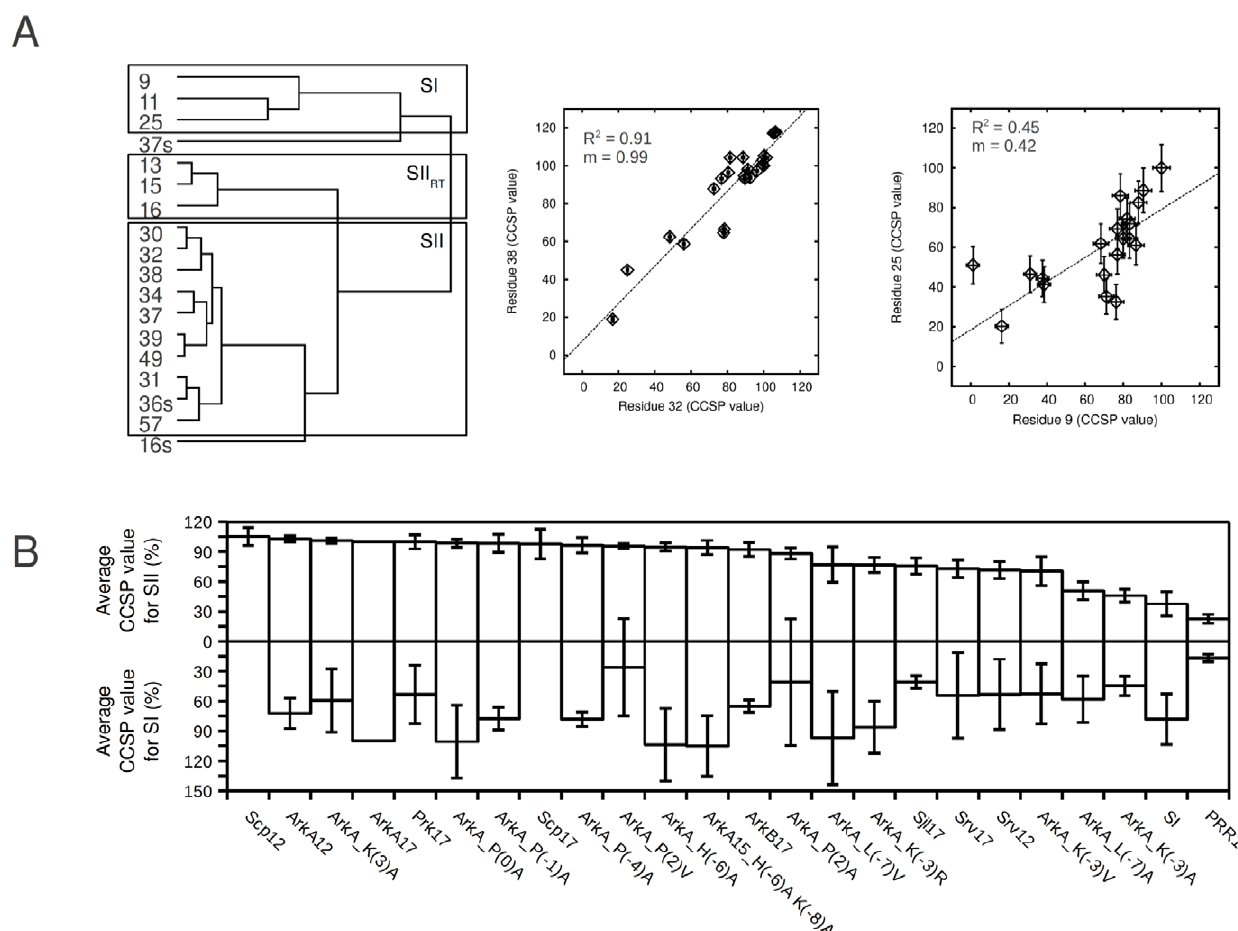
Figure 5. CCSP analysis of 24 AbpSH3-peptide complexes. (A) Left. CCSP values from 24 different peptide complexes are used in multiple pairwise comparisons to group correlated residues into a dendogram where the shorter the line connecting items indicates a closer relationship. The dendogram is grouped in three sections indicating correlated groups of residues for SI (top box), the SII portion of the RT loop tip (middle box) and SII (bottom box) that are used in this study. The side-chain NH groups of residues are denoted by the residue number followed by an ‘‘s’’. The programs Cluster 3.0 and Java TreeView 1.1.5r2, were used for the clustering analysis and tree visualization, respectively. Right. 2 pairwise correlations of CCSP data (V32 vs. L38 and D9 vs. K25). (B) Average CCSP values for SI and SII. Bars indicate 6 95% confidence intervals for the average and are substantially larger for SI, due to chemical shift changes occurring amongst a fewer number of residues and with smaller magnitudes in this region. Missing average values indicate residues contributing to the average were considered contaminated by our selection